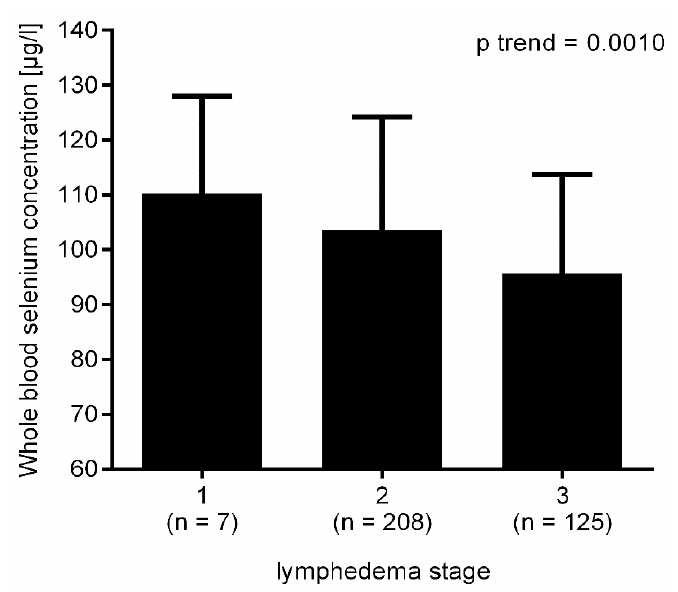
Figure 1. Decreasing selenium values with increasing lymphedema stage.